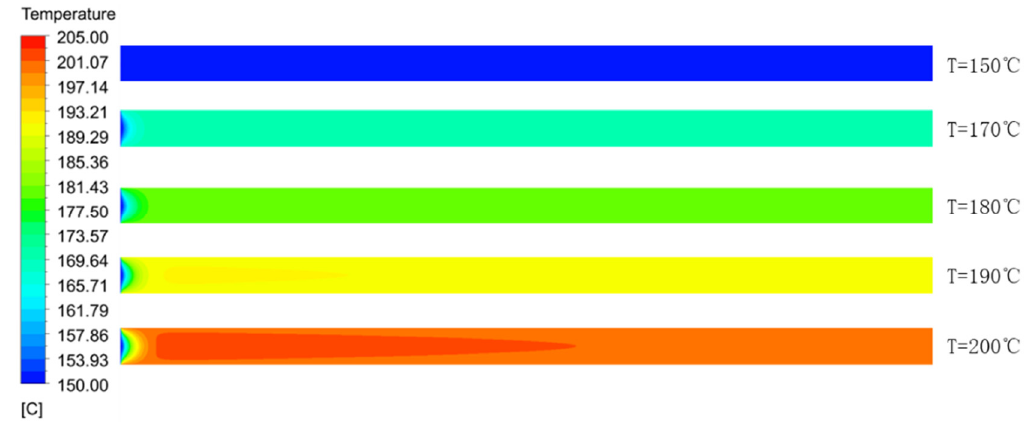
Figure 11. Temperature distribution cloud diagram of the axial section of the microreactor at different jacket temperatures.